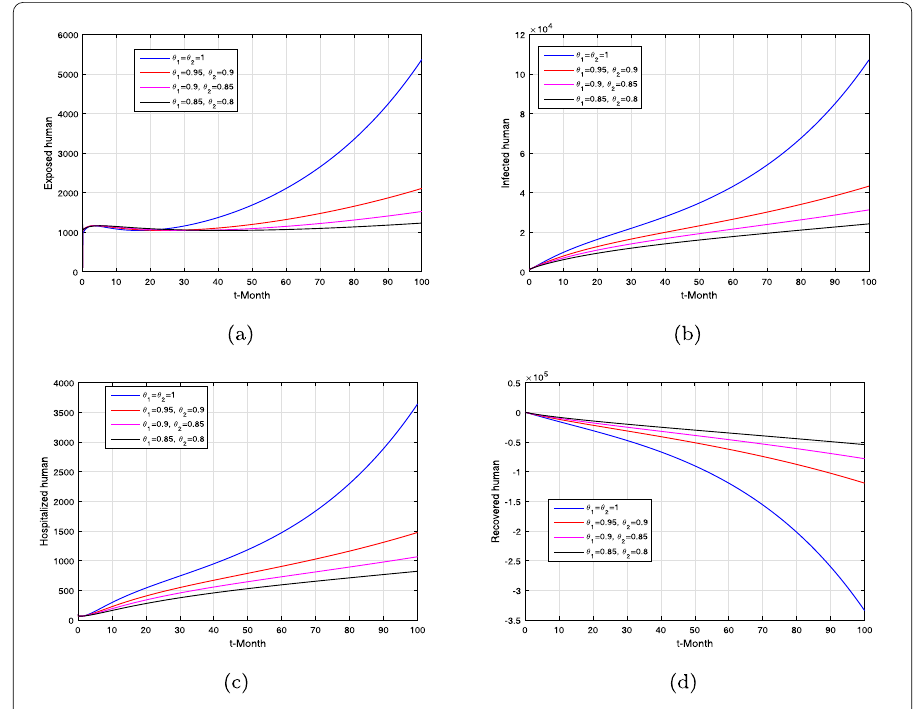
Figure 9 Simulation of the fractal-fractional model (10) when θ 1 = 1,0.95,0.9,0.85 and fractal order θ 2 = 1,0.9,0.85,0.8 where ( a ) exposed humans, ( b ) infected humans, ( c ) hospitalized humans, ( d ) recovered